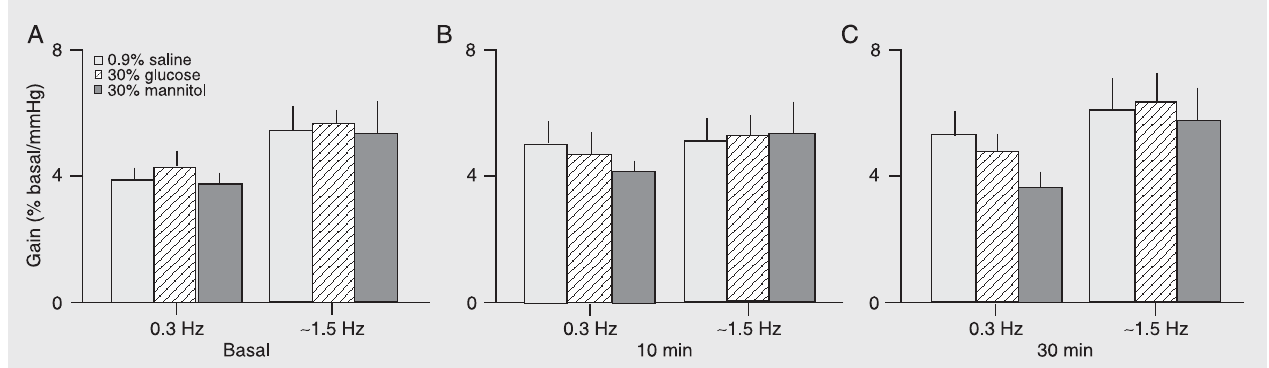
Figure 4. Gain of aortic depressor nerve (ADN) sensitivity (% of basal ADN activity/mmHg) assessed by transfer function magnitude obtained by cross- spectral analysis between mean arterial pressure and ADN activity during induced low frequency (0.3 Hz) oscillation and high frequency (~1.5 Hz) spontaneous oscillation before (Basal, A) and after (10 min, B; 30 min, C) the beginning of intravenous infusion of 30% glucose, 0.9% saline or 30% mannitol. Data are reported as means ± SEM for 7 rats in